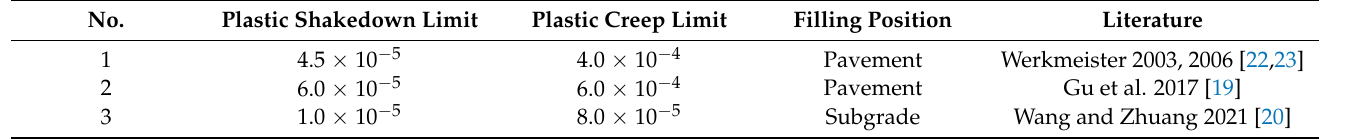
Table 1. The shakedown and creep limits determined by ∆ ε p ,5000 − ∆ ε p ,3000 from different studies.